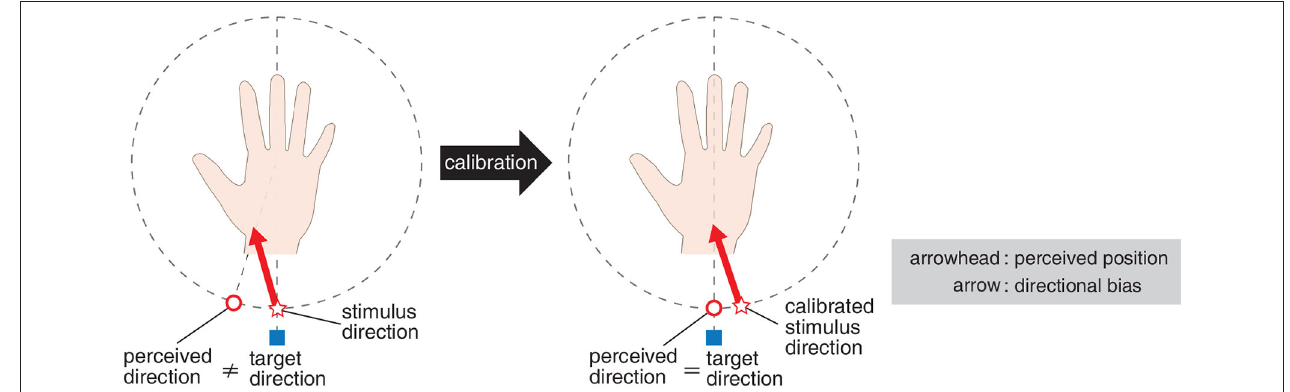
FIGURE 9 | Calibration of stimulus direction in order to make the user recognize the target direction